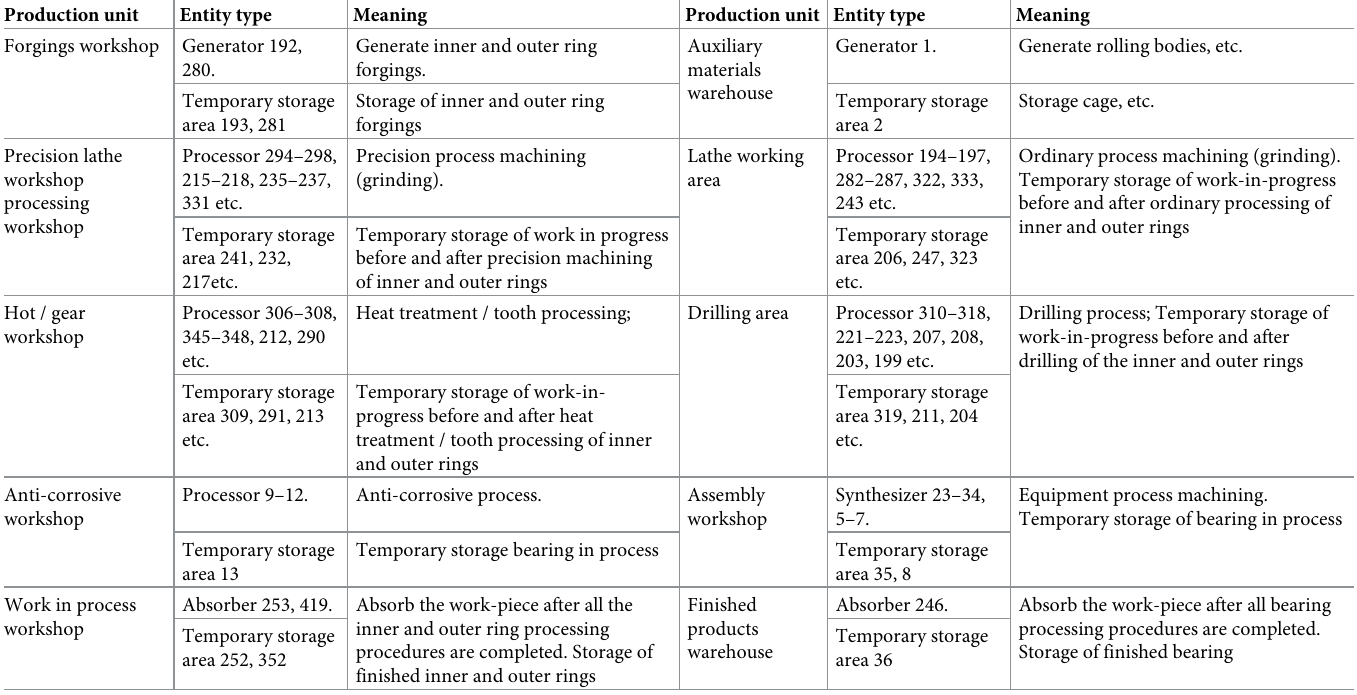
Table 7. Entity name, meaning and corresponding production